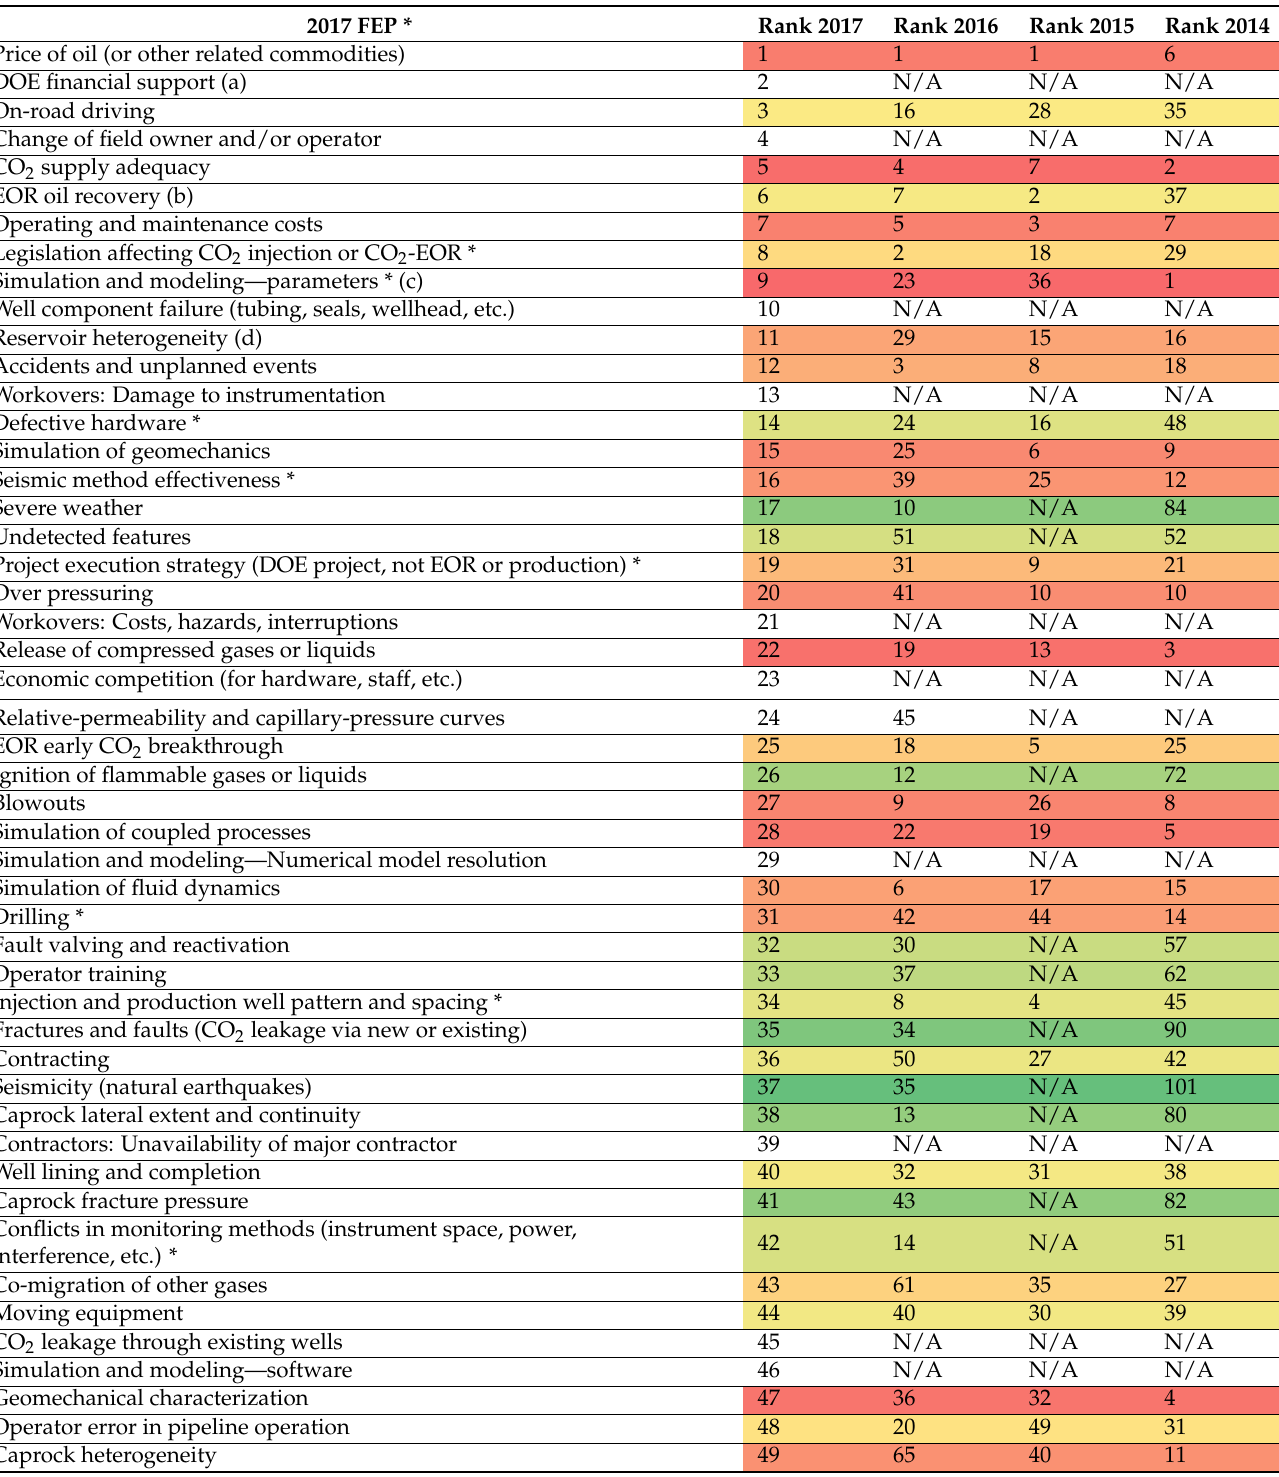
Table 2. Features, Events, and Processes (FEPs) rankings of four annual evaluations since 2014. Thirteen FEPs evaluated in 2016, but not in 2017, are listed at bottom. FEPs whose titles were worded slightly differently in prior years are indicated by an asterisk. FEPs not evaluated during a particular year are shown ranked as “N/A.” For most FEPs the related specific risks are evident to CCS practitioners; certain FEPs followed by a letter in parentheses are further explained below the